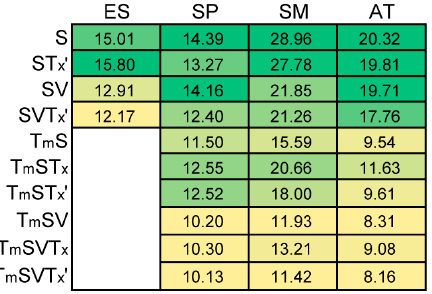
Figure 6. Cross-validated MERs using different feature sets for RF classifiers.